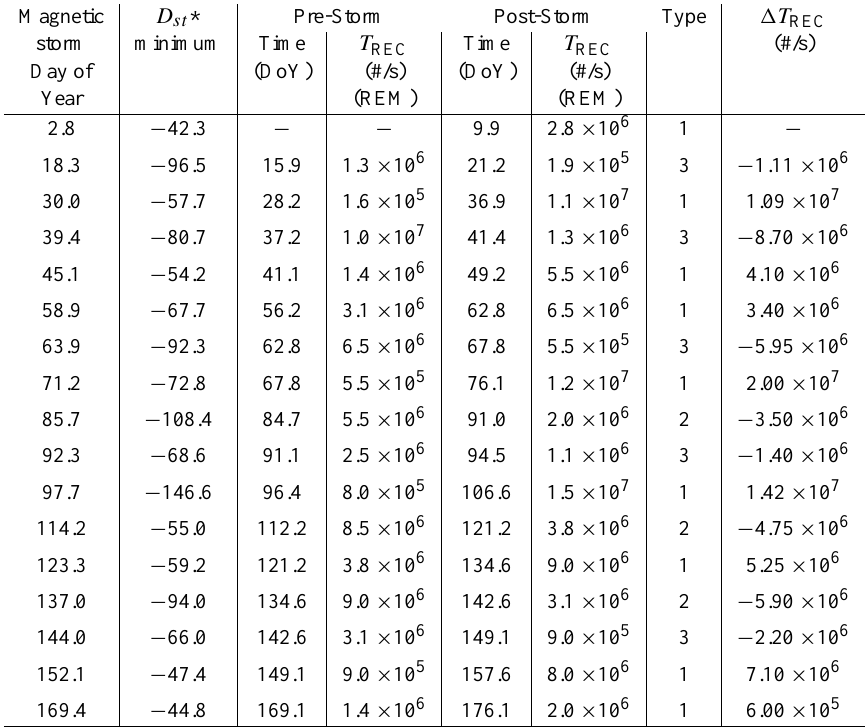
Table 2. The day of year and value of the D st * minimum for each event, together with the pre- and post-storm T REC for the REM measured at the beginning and end of each storm interval and the associated event type and change in T REC Magnetic D st *